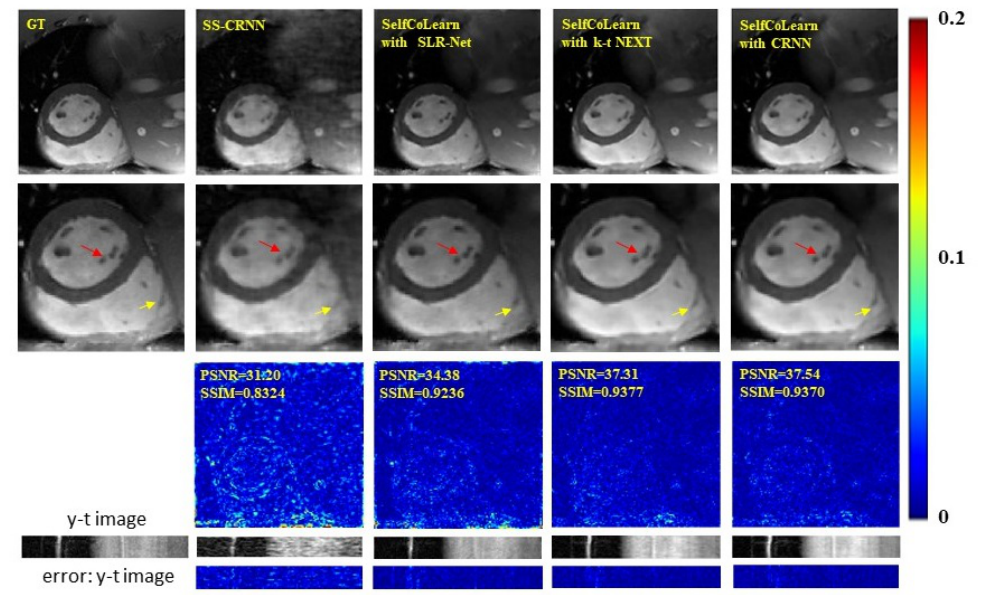
Figure 5. Reconstruction results of SS-CRNN and the proposed SelfCoLearn with SLR-Net, k-t NEXT, and CRNN backbone networks at 8-fold acceleration. The first row shows ground truth (fully sampled image), the reconstruction images of SS-CRNN and the proposed self-supervised learning strategy with SLR-Net, k-t NEXT, and CRNN (10th frame). The second row shows their enlarged images in the heart regions. The third row plots the error images of these two methods. The last two rows show the y-t images (the 40th slice along the dimensions of y and t) and the corresponding error images.